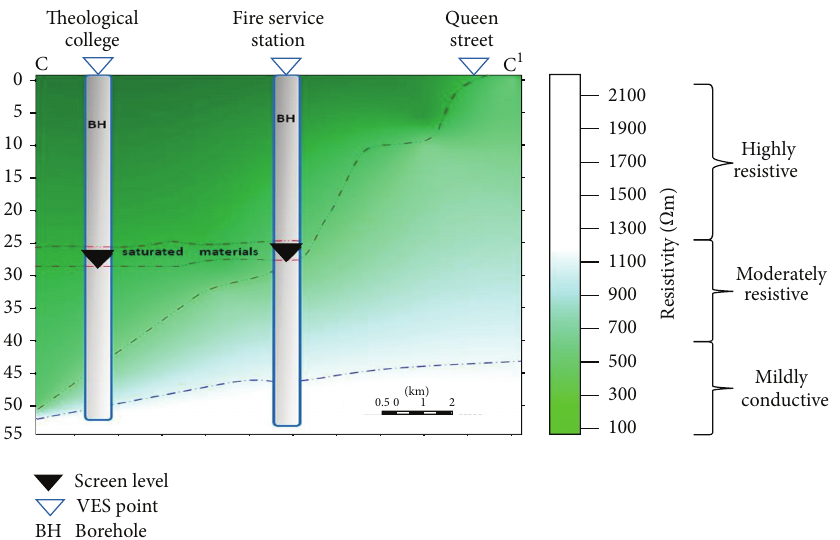
Figure 7: Resistivity cross section along a profile from Agric. secretariat to Local G. Area Secretariat (C-C 1 ).